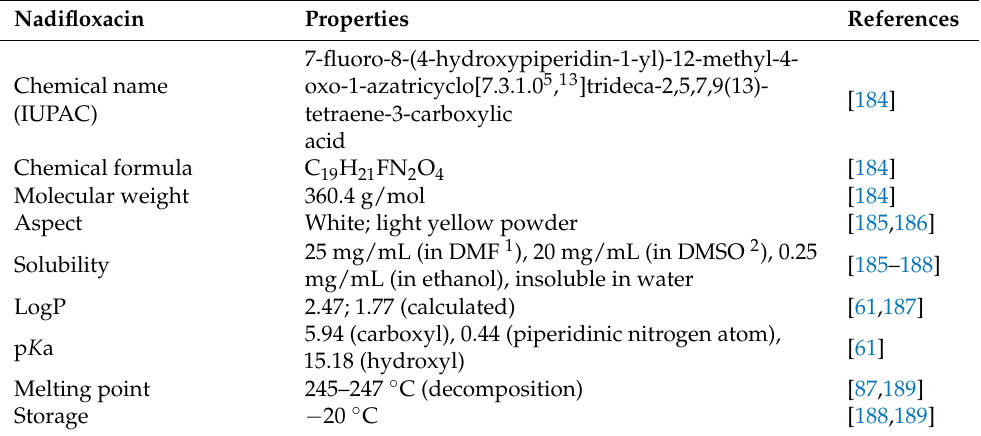
Table 7. Physicochemical properties of